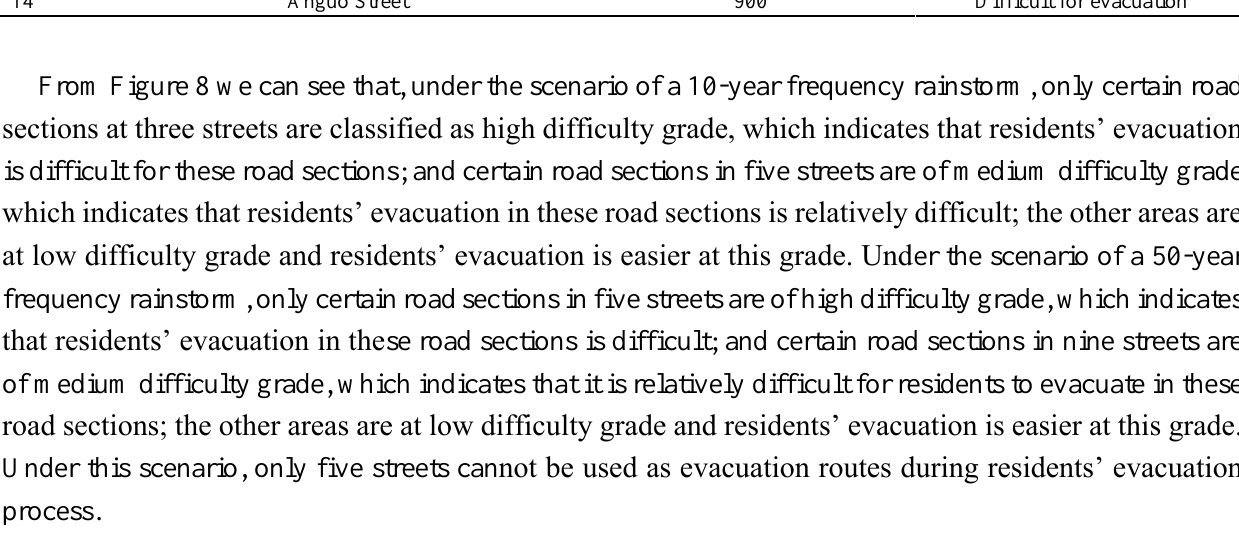
Figure 8. Difficulty evaluation of residents’ evacuation at urban rainstorm waterlogging disasters: ( a ) Difficulty evaluation of residents’ evacuation under the scene of 10-year; ( b ) Difficulty evaluation of residents’ evacuation under the scene of